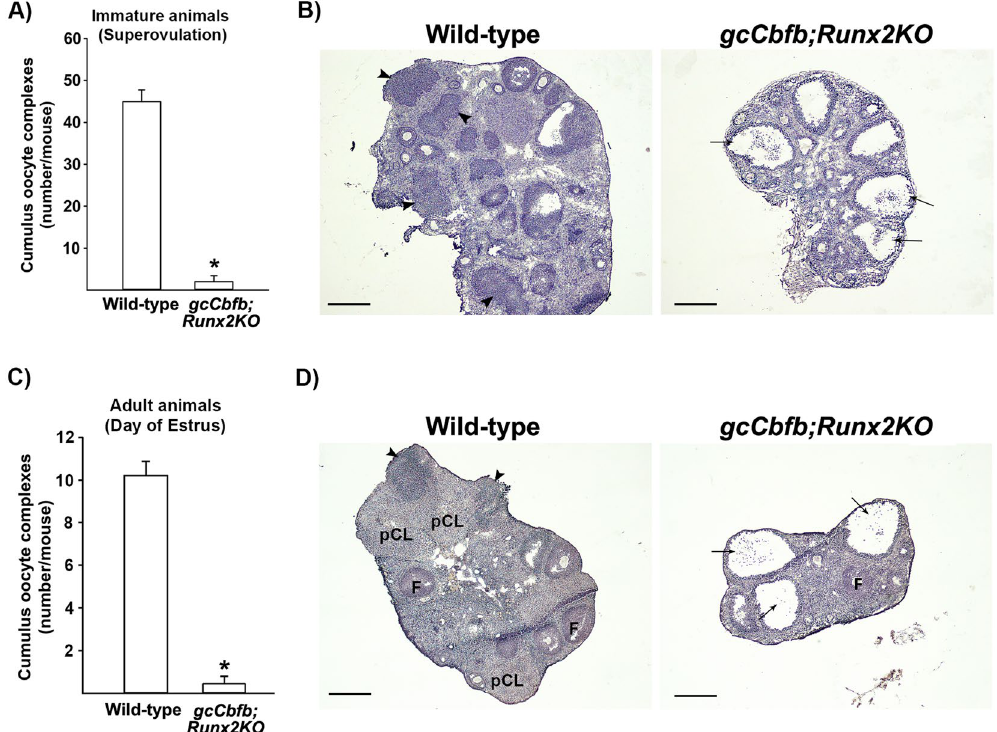
Figure 2. gcCbfb;Runx2KO mice failed to ovulate. ( A & B ) Immature wild-type and gcCbfb;Runx2KO mice primed with PMSG/hCG were killed between 16–24 h after hCG administration and cumulus oocyte complexes (COCs) were collected from oviducts and counted (A), and their ovarian morphology was examined ( B ) (n = 13 and 8 for control and mutant mice, respectively). * p < 0.001. ( C & D ) Adult mice were euthanized in the morning of estrus (marked as E * in Fig. 1F). COCs were collected from oviducts and counted ( C ), and their ovarian morphology was examined ( D ) (n = 5 and 9 for control and mutant mice, respectively). * p < 0.001. Arrows and arrowheads point to large antral follicles with expanded cumulus cells and newly forming CL, respectively. pCL; CL generated from previous cycles. F; follicle. Scale bars, 500 μ m for all